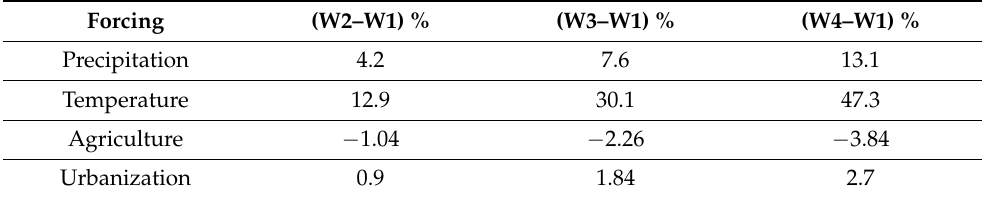
Table 3. Percentages change in forcing from the historical climate